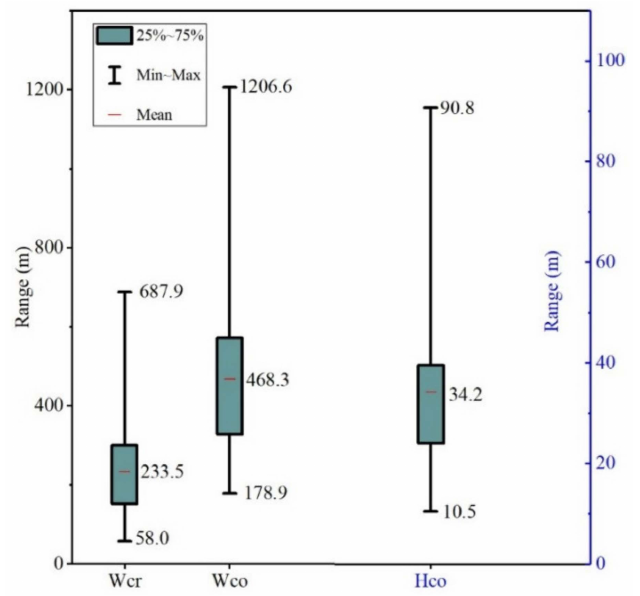
Figure 3. Box and whisker plots for three morphometric parameters data distributions of the landing area cones. Wcr and Wco refer to the left vertical axis, while Hco refers to the right vertical axis.